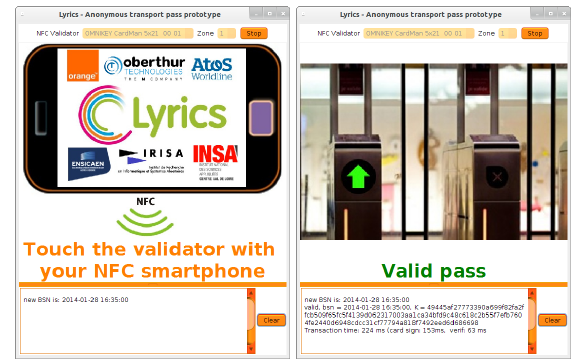
Figure 5. Validation